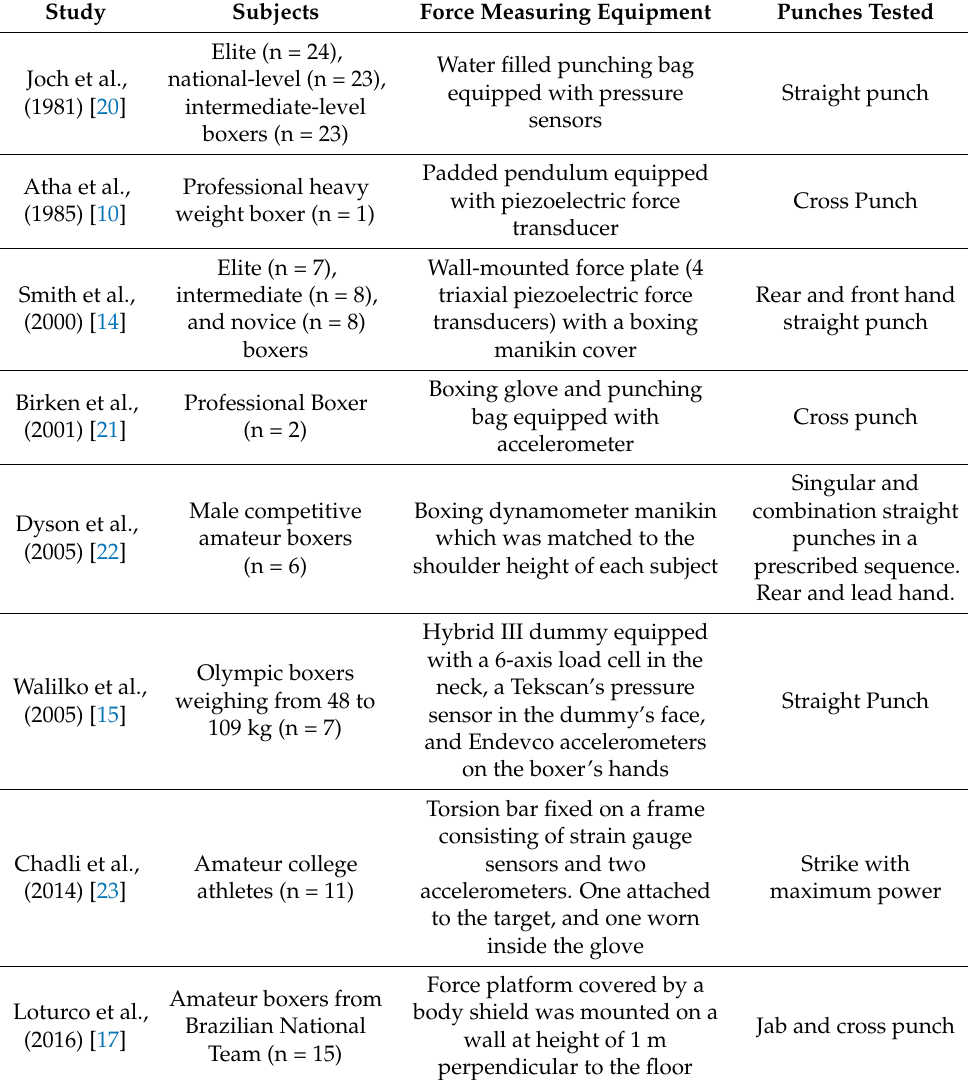
Table 1. Dynamometry in the punching force literature modified according to Lenetsky [12] (p. 2) in chronological